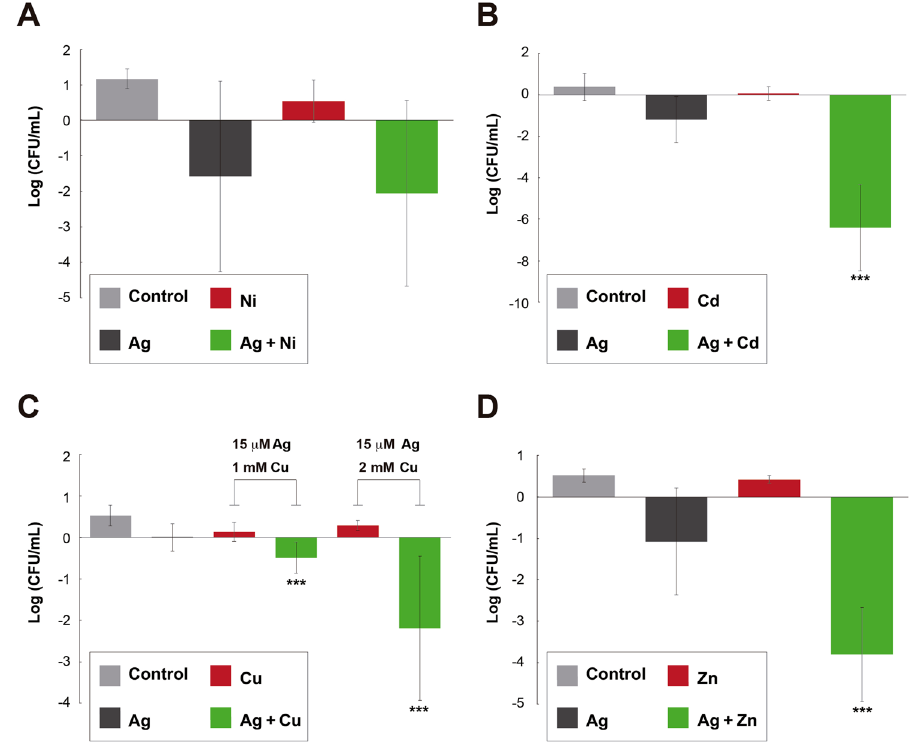
Figure 5. Bactericidal Effect of Ag Potentiated by Transition Metals. Log change in CFUs/mL with respect to time zero, in Escherichia coli ATCC 11229 after 1 hour treatment with: LB (control), Ag, specific transition metal and their combination. As nominal concentrations: ( A ) Ag 30 µ M, Ni 0.5 mM and the combination; ( B ) Ag 30 µ M, Cd 1 mM and the combination; ( C ) Ag 15 µ M, Cu 1 mM and 2 mM, and the respective combinations; ( D ) Ag 30 µ M, Zn 0.5 mM and the combination. *** Corresponds to a p < 0.05, tested with an ANOVA, that there is a difference with respect to the control and each of the individual treatments. Error bars correspond to the standard deviation from experiments performed in